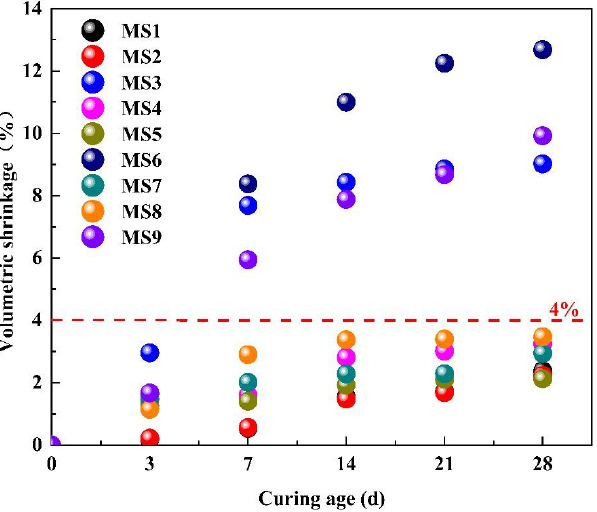
Figure 2. Volume shrinkage of solidified sludge samples.